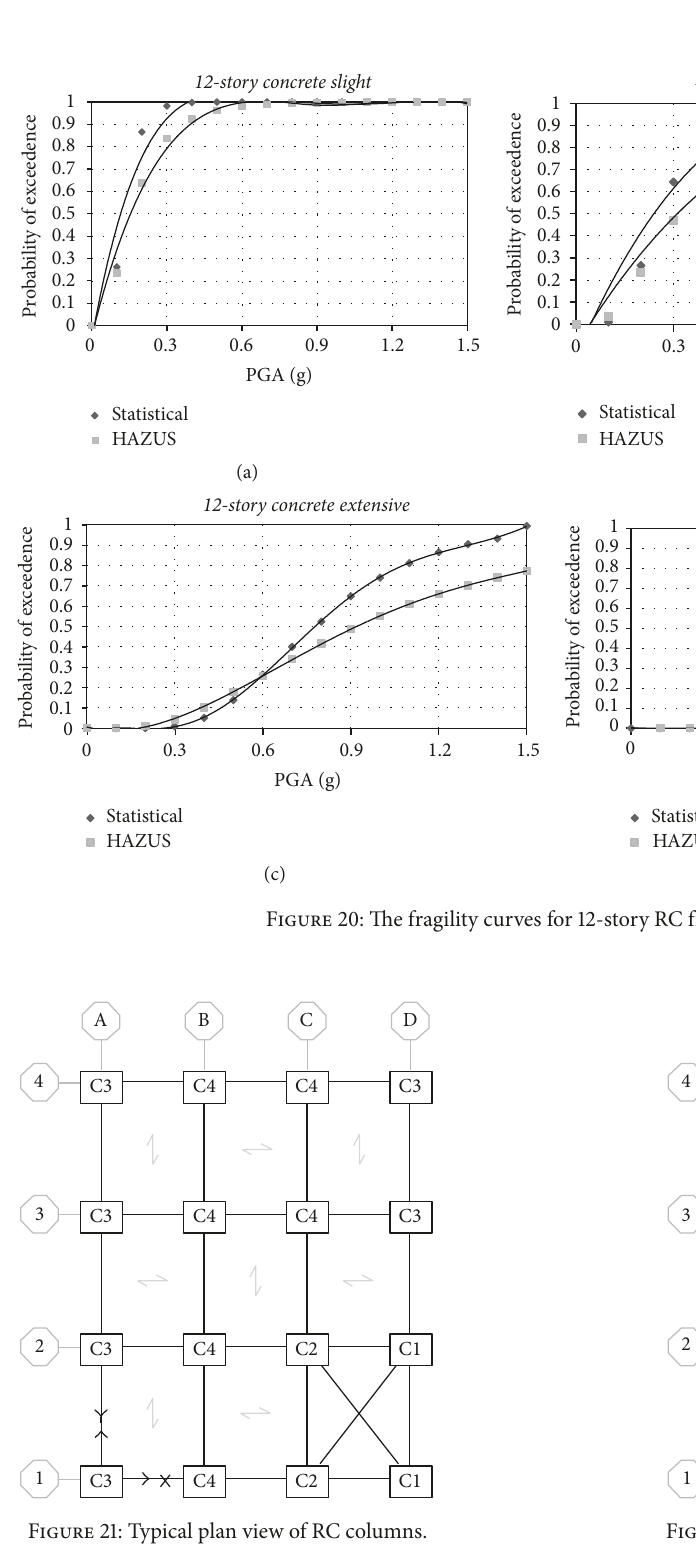
difference can be seen in the extensive damage state (statis- tical method yields 20% higher fragility). In other states, the curves are fairly close